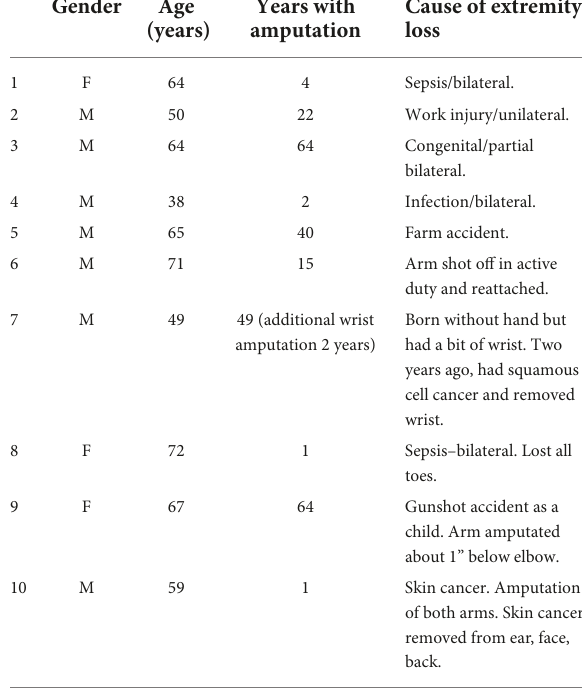
TABLE 1 Hand absence interview